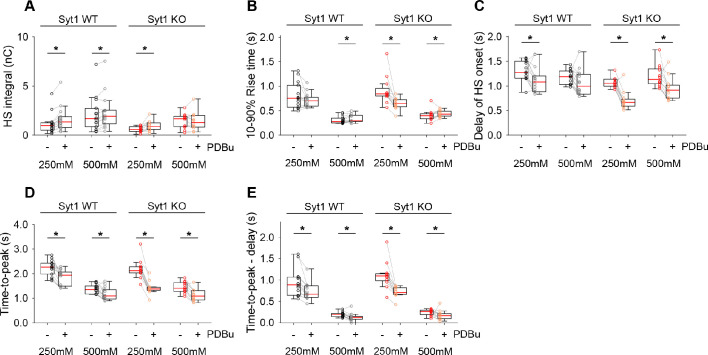
Additional HS parameters before and after PDBu in Syt1 WT and KO neurons.(A) Integral of current from HS-induced release at different concentrations. (B) 10–90% rise time of peak HS-induced current. (C) Time delay after application of HS before onset of release. (D) Time from start of HS application till peak HS-induced current. (E) Time from start of HS application till peak HS-induced current, corrected for the delay in release onset after HS application. All panels comparing before (-) and after (+) PDBu (*p<0.05, Wilcoxon signed-rank test).
Figure 6—figure supplement 1—source data 1.Statistics overview.